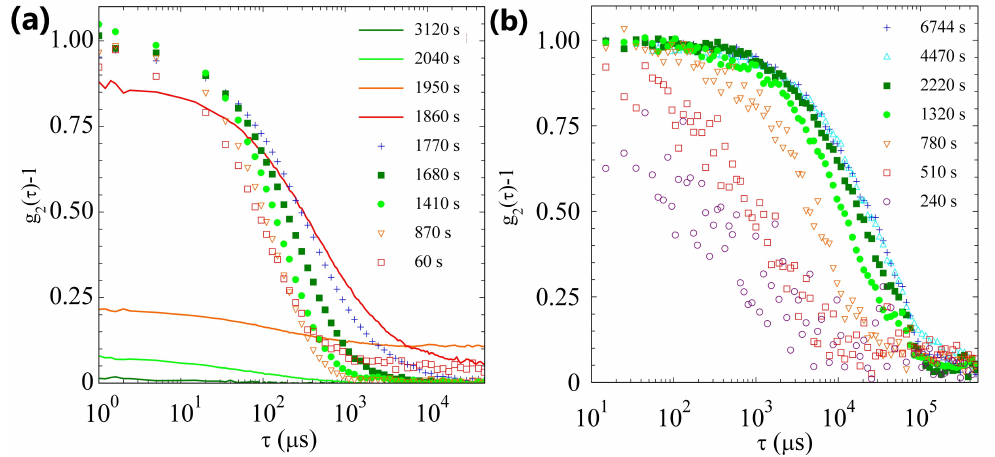
Figure 5. ( a ) ICFs at different times, indicated in the legend, for sample H. Symbols stand for ergodic samples, while continuous lines indicate ICFs taken after t g , when the time averaged ICF is no longer reliable. ( b ) ICFs at different times, indicated in the legend, for sample